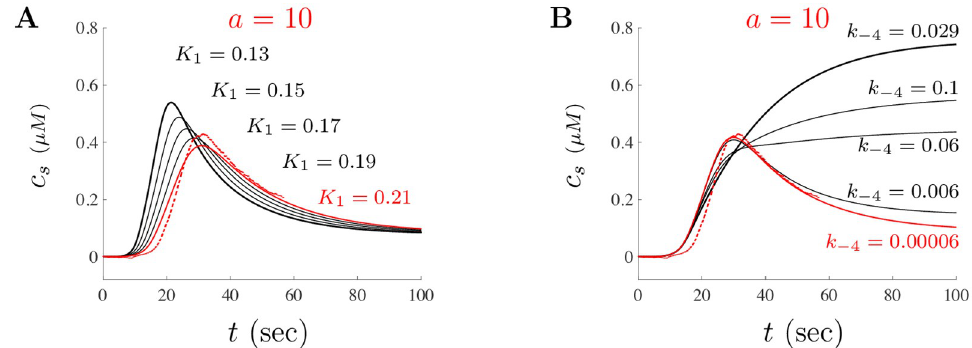
Fig 11. Impact of large doses of A β on IP 3 R dynamics. The impact of the IP 3 R model parameters K 1 and k − 4 are shown in A and B , respectively. The traces shown use the large doses parameters except for the values highlighted in each diagram. The top bold black traces correspond to the model solution when the parameter value for the small doses is used. The red traces are the model solutions for the parameter values of the large doses. The black traces between the bold and red correspond to intermediate parameter values as given in each